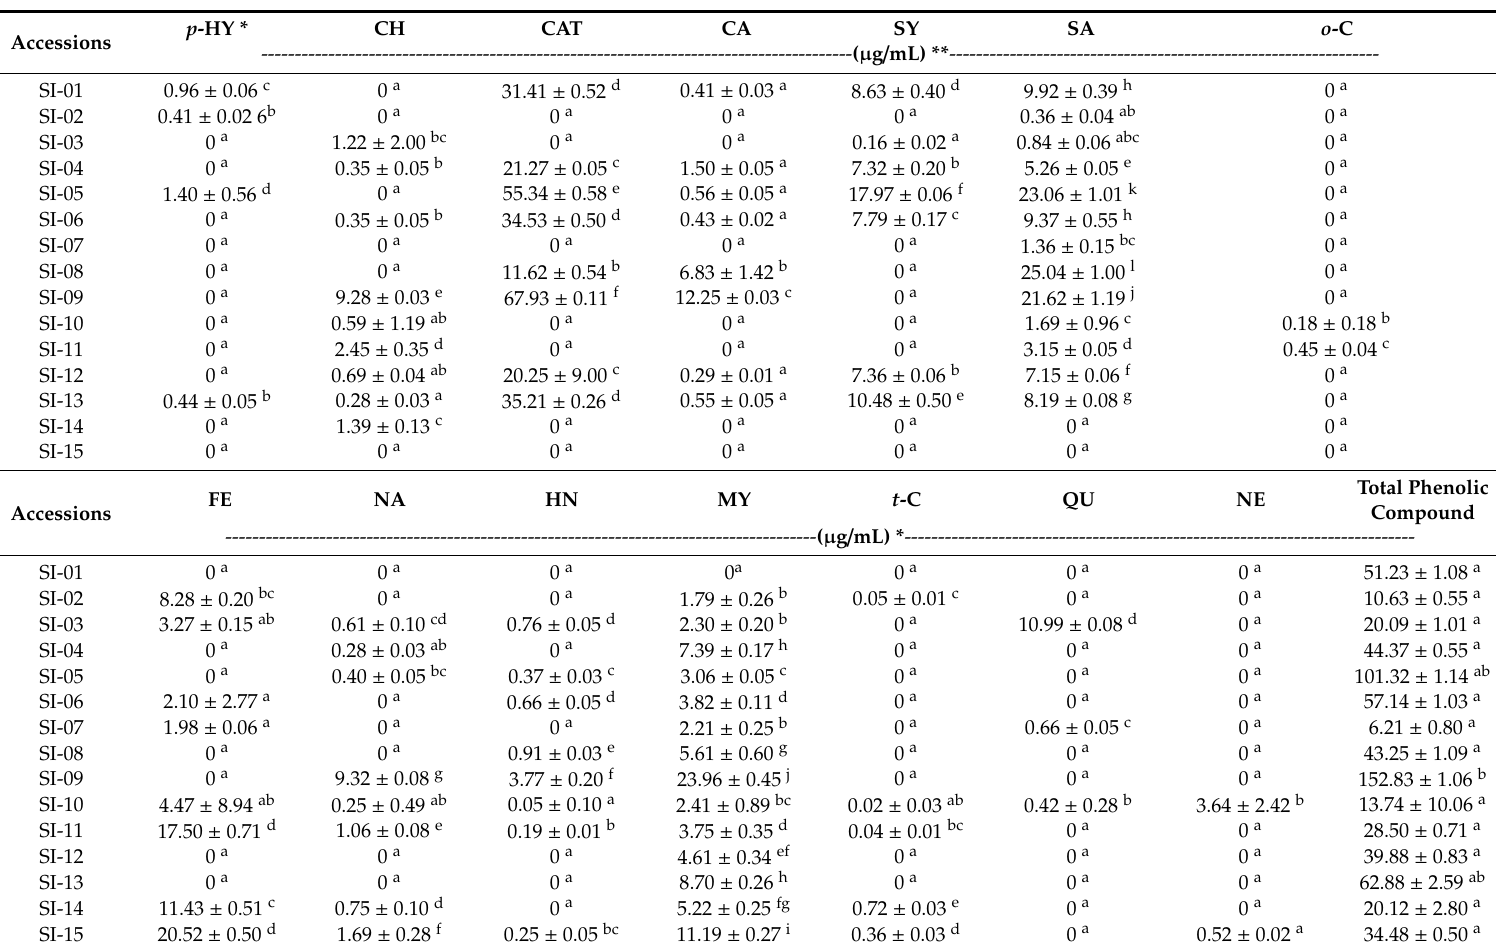
Table 5. Distribution of total phenolic compounds in the di ff erent accession of S. italica